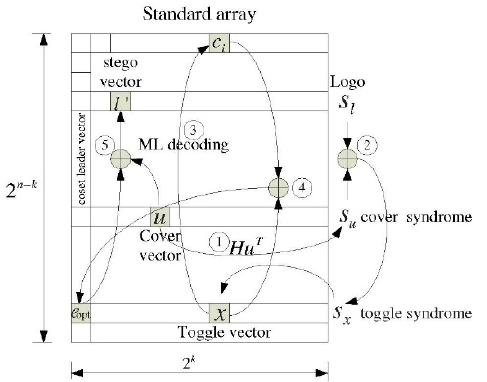
Figure 3. Standard array for the embedding algorithm.